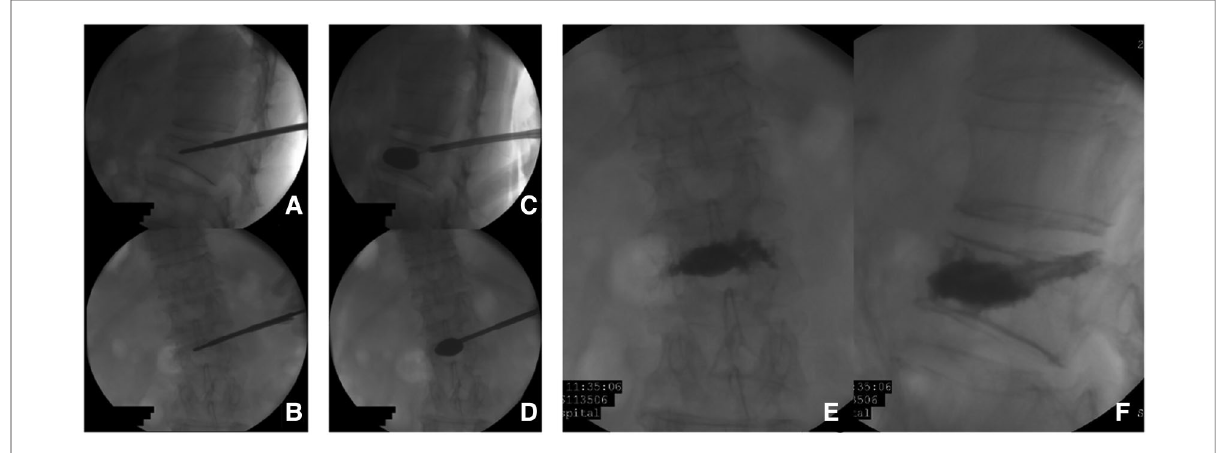
FIGURE 4 Percutaneous kyphoplasty using a single-balloon device preformed in L2 lumbar vertebra. ( A – D ) the imaging of cement augmentation after kyphoplasty ( D,E ).